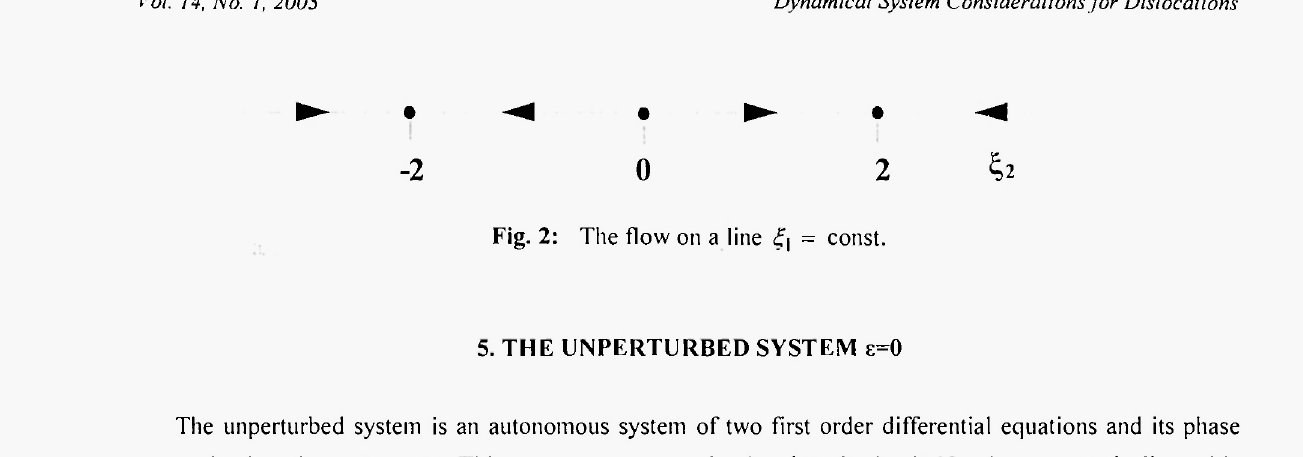
Fig. 2: The flow on a line ξ\ =